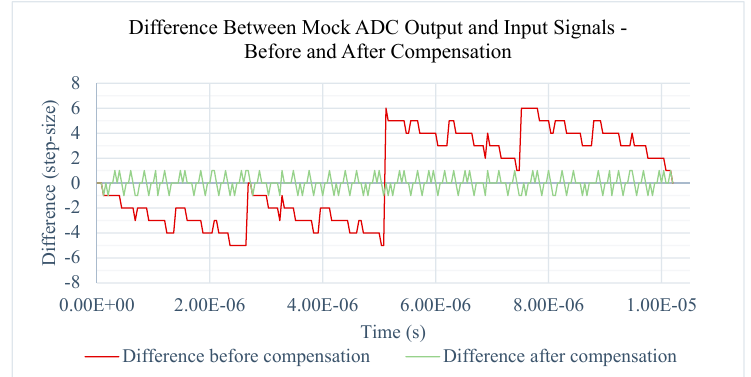
Figure 16. Difference between output and input signals of the TM-based ADC Very high speed integrated circuits Hardware Description Language (VHDL) model before and after compensation.